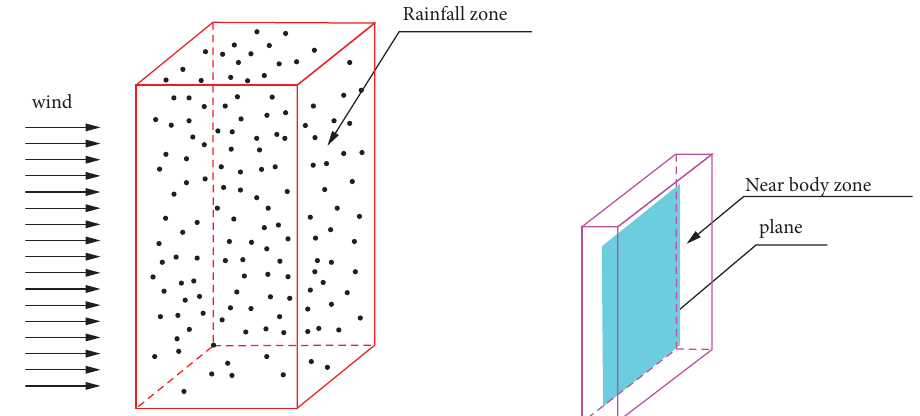
Figure 24: Distribution of rain load calculation domain per unit area of fat plate.